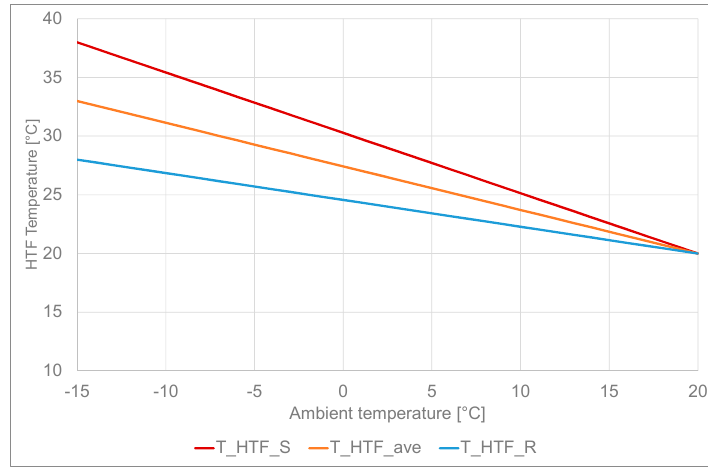
Figure 4. Supply, return and average heat transfer fluid ( HTF ) temperature as a function of ambient temperature for a reference case with T a,N = − 15 °C, T S,N = 38 °C and T R,N = 28 °C.